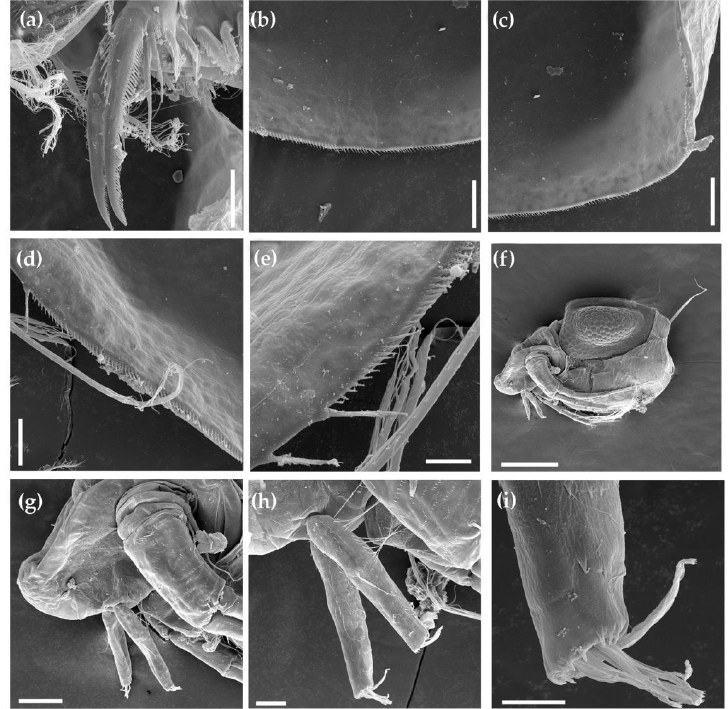
Figure 8. Moina cf. micrura , parthenogenetic ( a – e ) and ephippial ( f – i ) females from Masfoot Dam 1, United Arab Emirates. ( a ) Postabdominal claws, ventral view; ( b , c ), armature of posterior margin of valve, inner view; ( d , e ), armature of posteroventral margin of valve, inner view; ( f ) ephippial female, lateral view; ( g ) head; ( h ) antenna I; ( i ) antenna I with higher magnification. Scale bars: 0.2 mm for ( f ), 0.05 mm for ( g ), 0.02 mm for ( a – d , h ), 0.01 mm for ( e , i ).